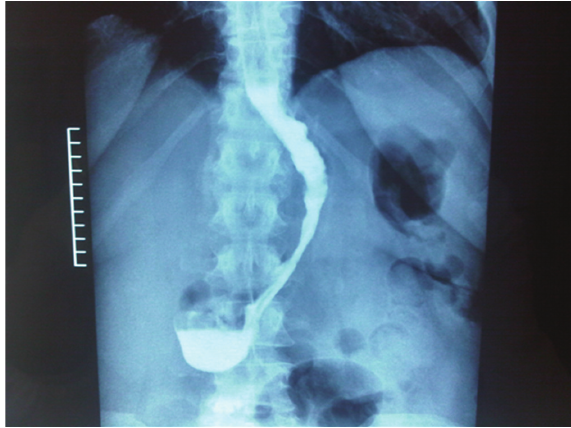
Figure 2: Postoperative swallow